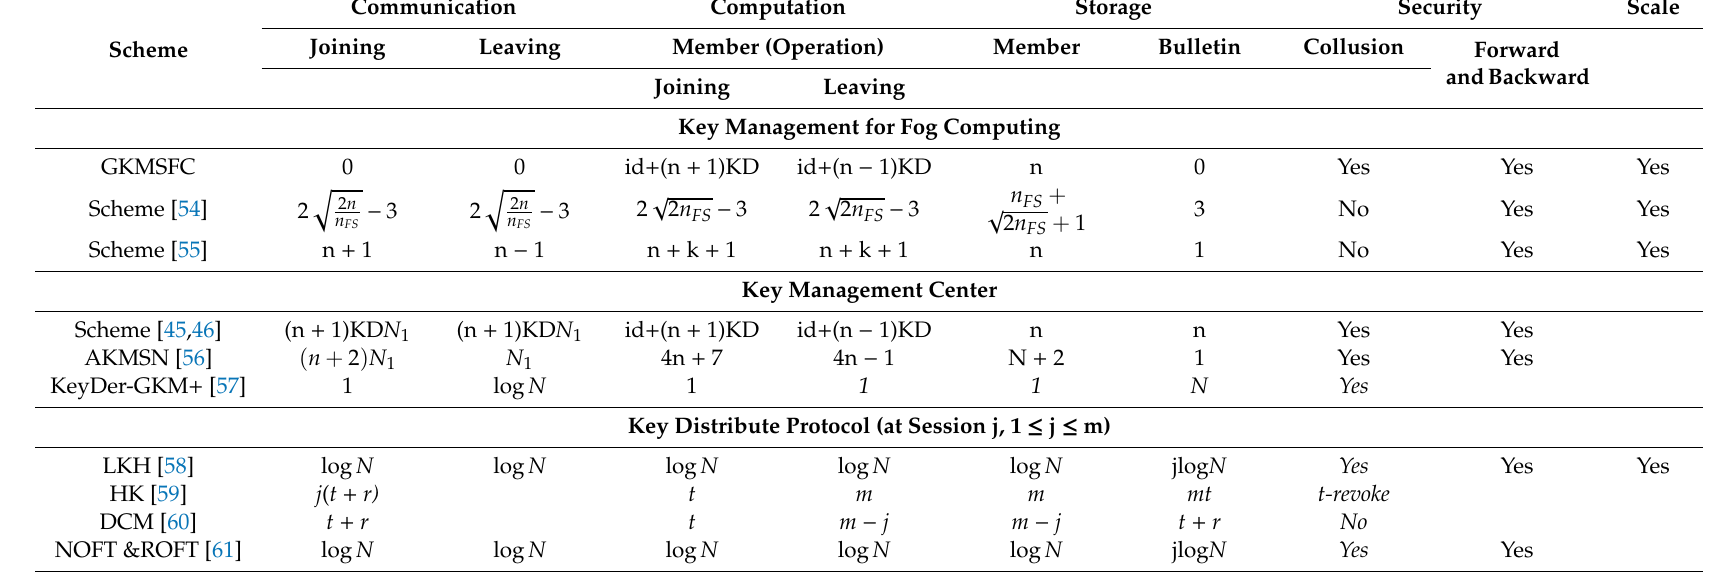
Table 1. Comparison of group key management (GKM) di ff erent